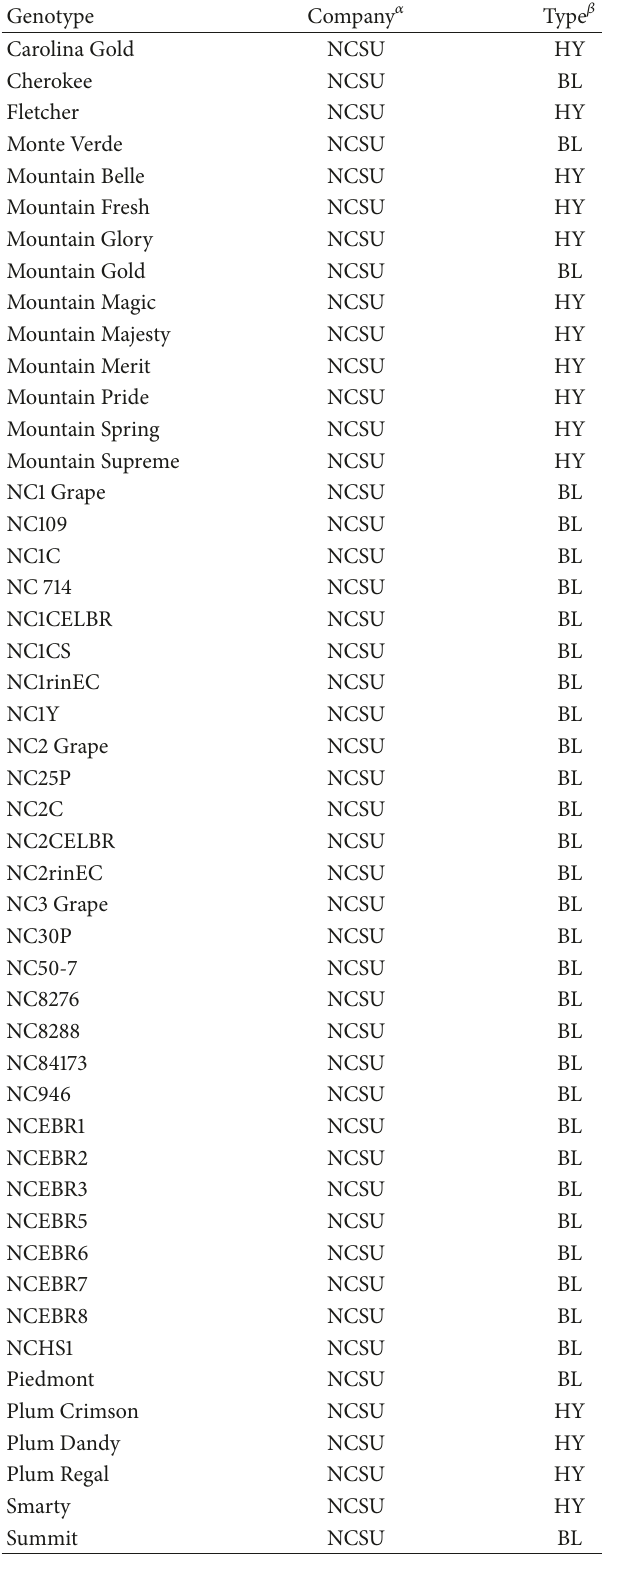
Table 1: List of fresh market tomato genotypes including breeding lines, advanced lines, and selections and hybrids that are being used or tested in tomato breeding programs for the development of new